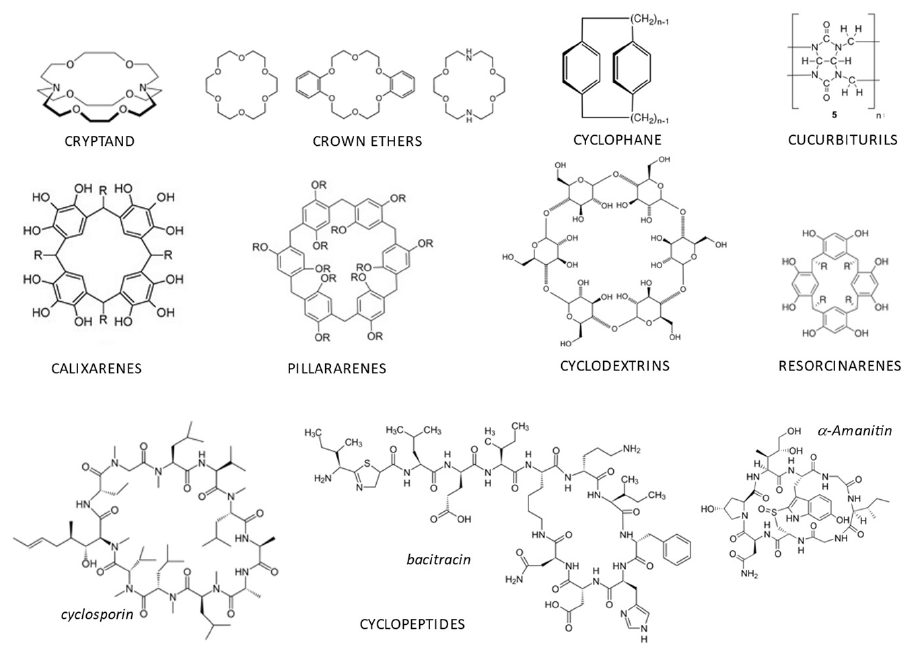
Figure 2. Typical host macrocyclic molecules .